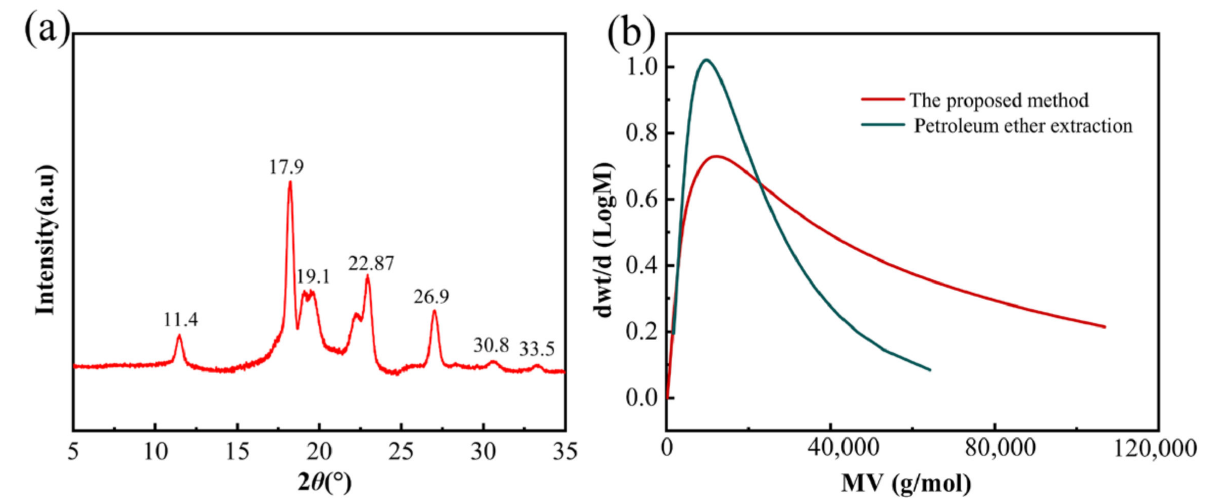
Figure 10. ( a ) XRD of the purified gutta-percha, ( b ) Molecular weight distribution curves of